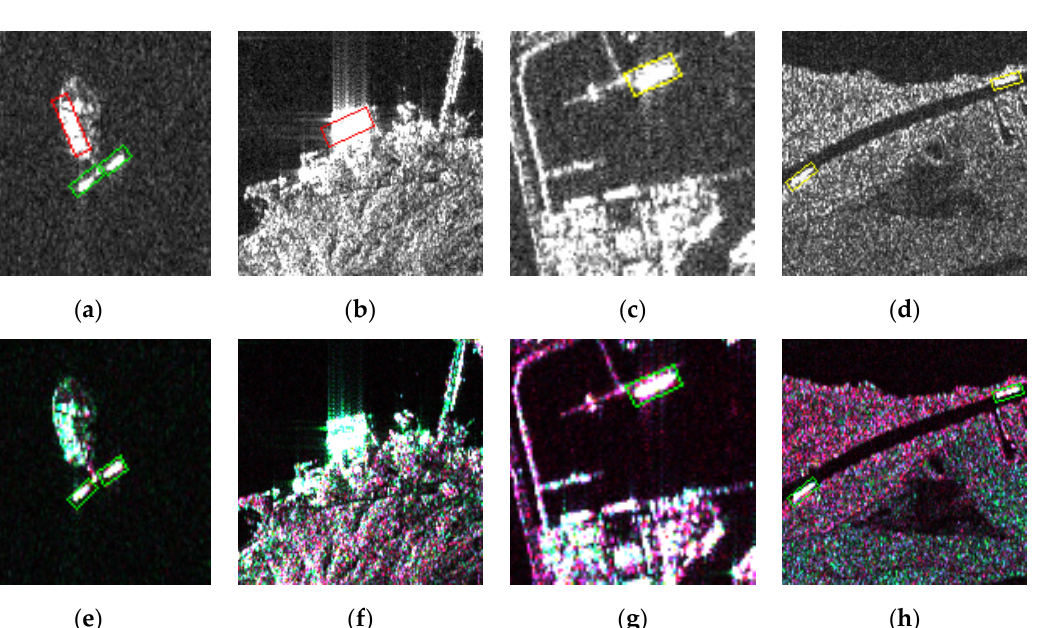
Table 3. YOLOv4 detection results on pseudo-color enhanced and the corresponding VV and VH polarized test set of DSSDD.